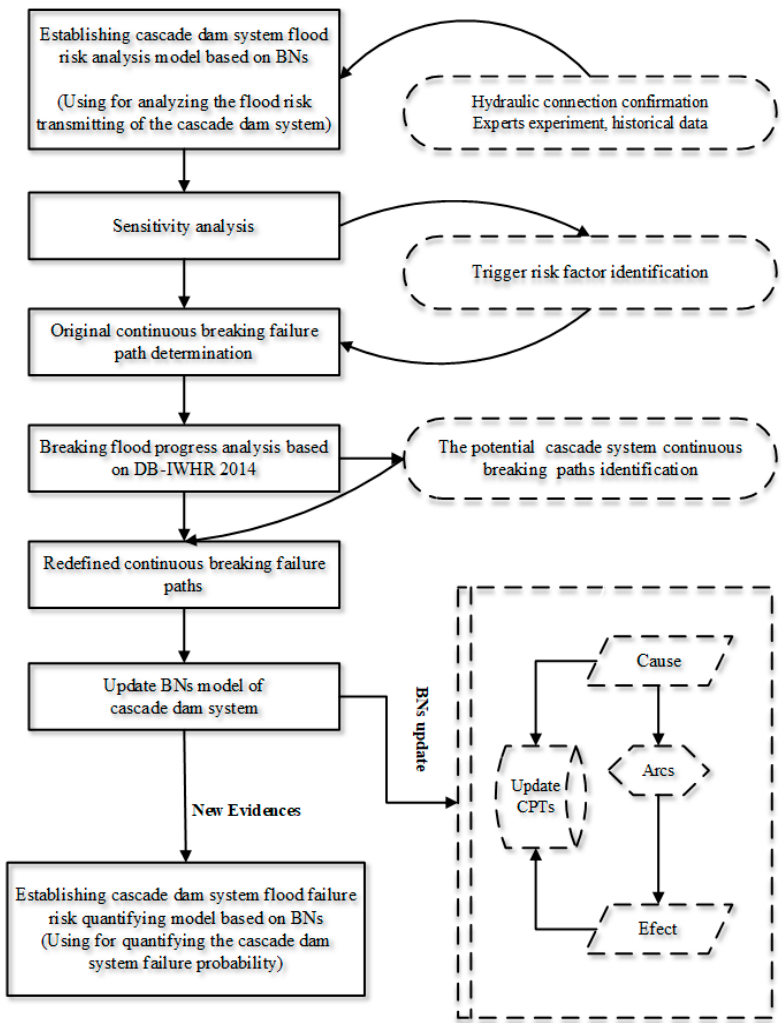
Figure 3. Risk analysis flow path of cascade dam system.